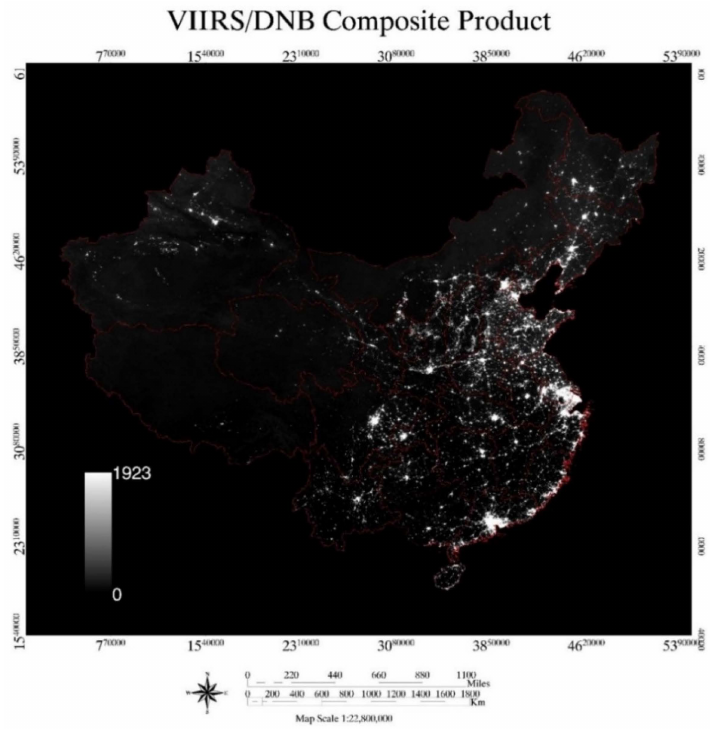
Figure 1. The VIIRS-day-night band (DNB) composite data of mainland China in 2013 (multiplying the pixel value by 10 ´ 9 gives radiance in units of W/cm 2